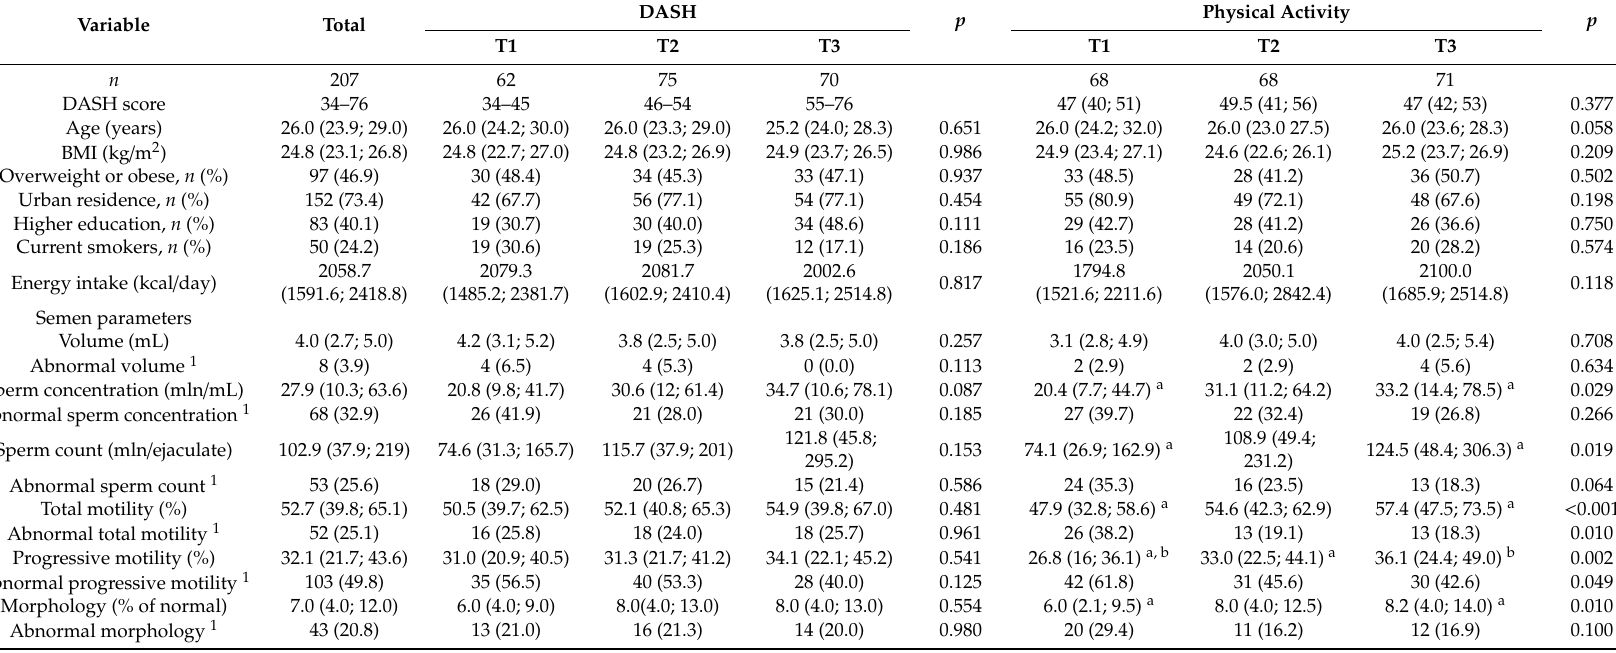
Table 1. Socioeconomics and semen quality characteristics among tertiles of dietary approaches to stop hypertension (DASH) score and physical